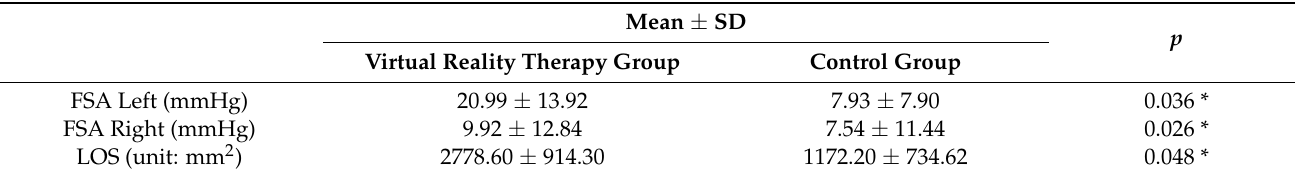
Table 4. Comparison of the differences after treatment in the two